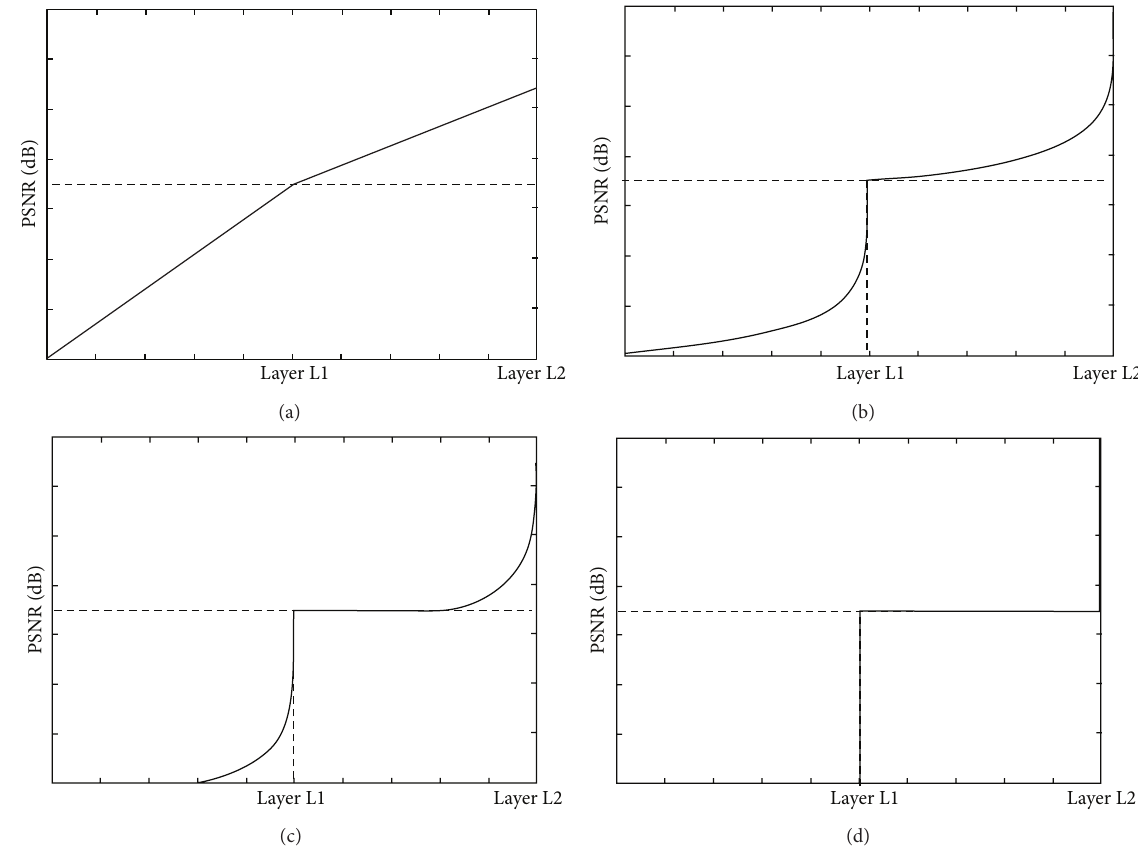
Figure 1: PSNR to the number of the packets received at a user in the four schemes.